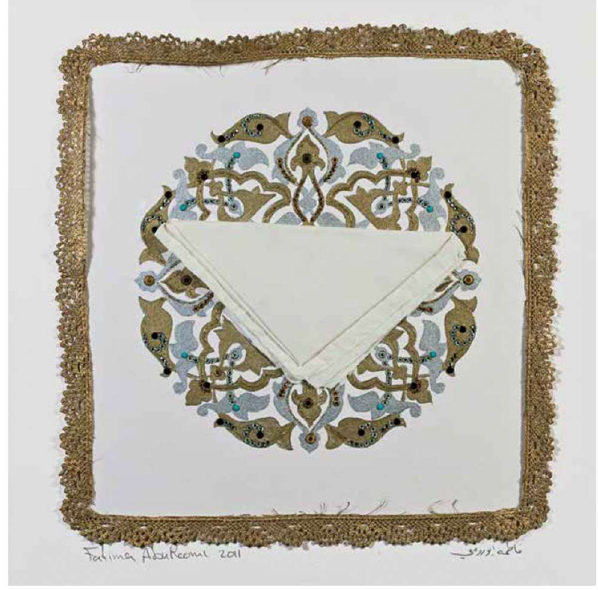
Figure 12. Fatima Abu Rumi, From the Bridal Kerchiefs series, 2009–2010, kerchief, acrylic and zircons 23 × 23 cm.